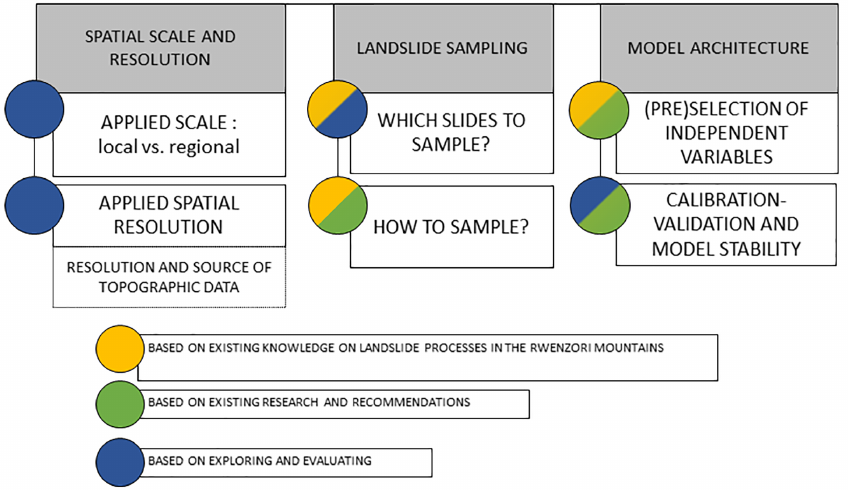
Figure 2. Schematic representation of the methodological options considered in this study and how they are evaluated and